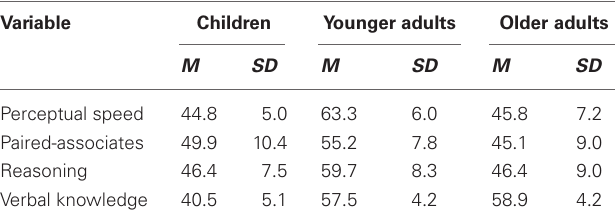
Table 1 | Cognitive characteristics of the age groups.